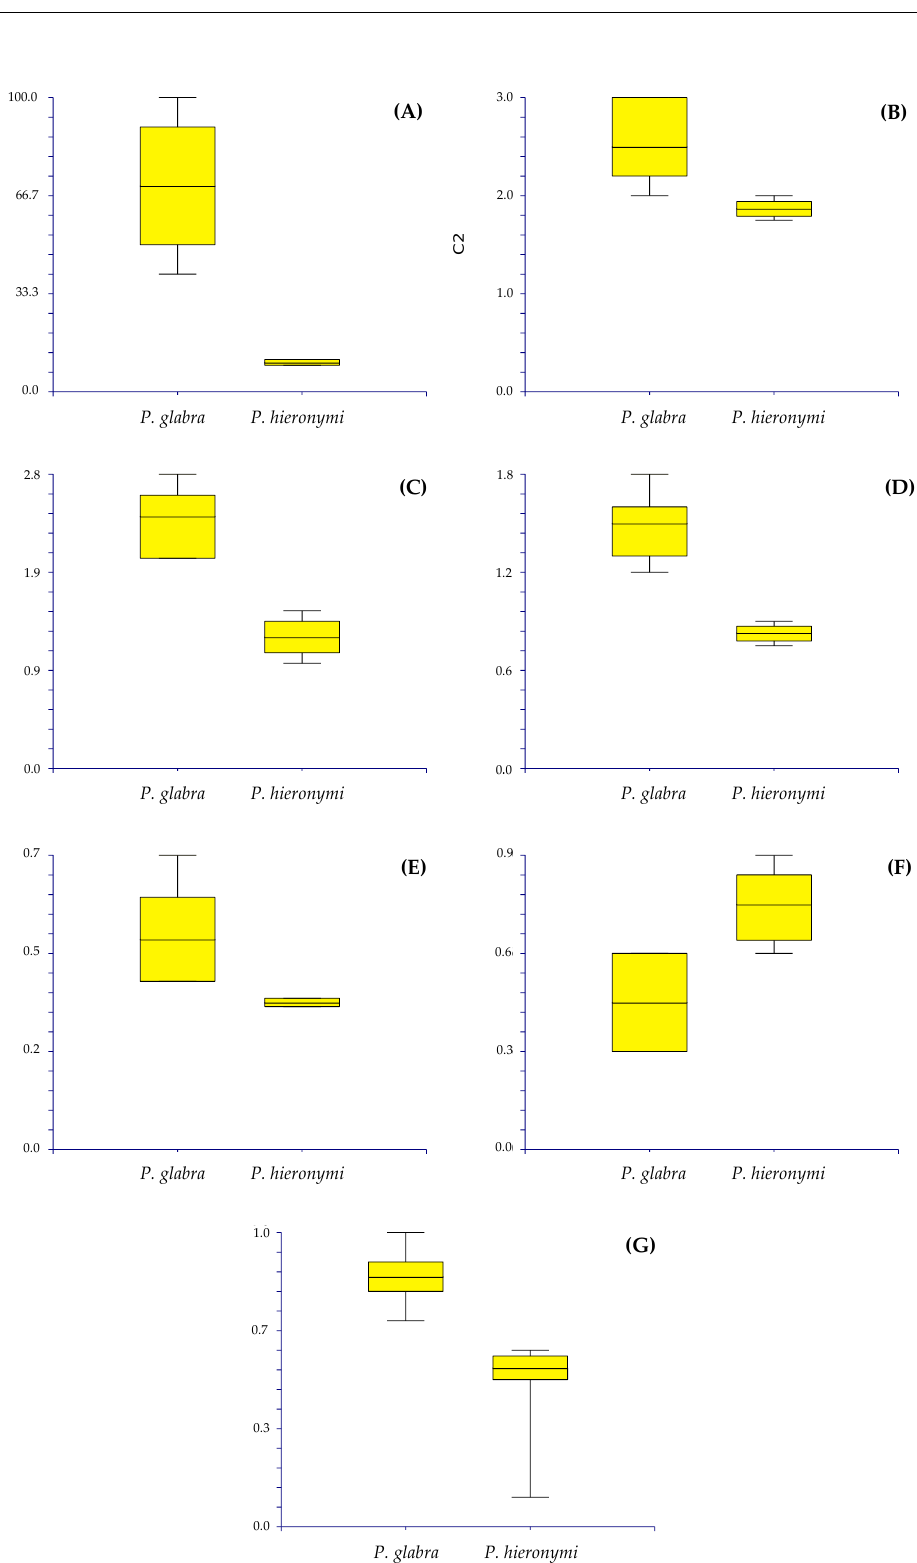
Figure 4. Paronychia glabra vs. P. hieronymi . Box plots illustrating the variability of: size of the stem ( A ), size of the flowers ( B ), length of the sepals ( C ), length of the petals ( D ), length of the anthers ( E ), length of the styles ( F ), length of the ovary ( G ). Yellow boxes illustrate interquartile ranges (25th–75th percentile) and medians (horizontal line); vertical lines are the whiskers (scores outside the middle 50%).